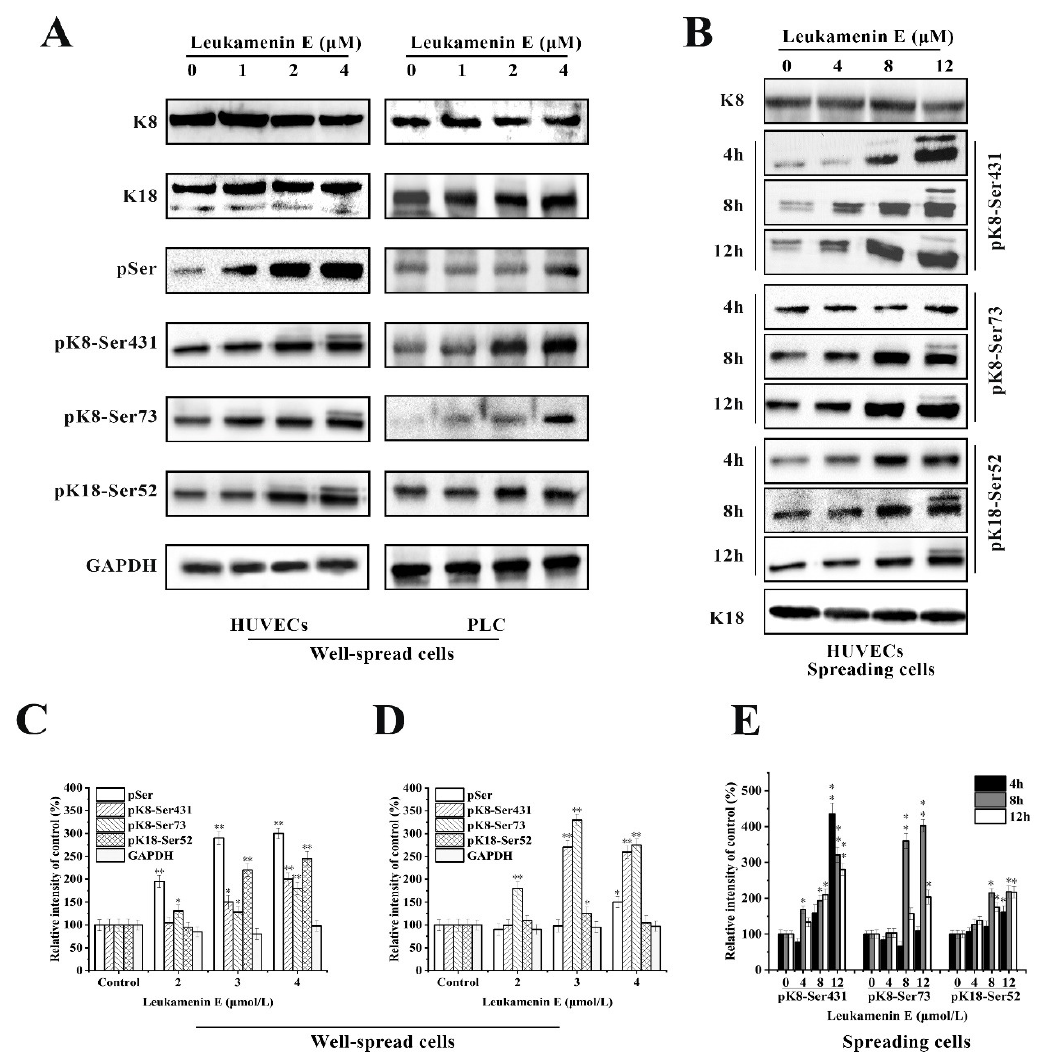
Figure 6. Effects of leukamenin E on keratin phosphorylation in PLC and HUVECs. ( A ) Leukamenin E stimulates phosphorylation of K8 at Ser73 and Ser431 and K18 at Ser52 but does not alter the expression of K8 and K18 in well-spread cells. ( B ) Leukamenin E stimulates phosphorylation of K8 at Ser73 and Ser431 and K18 at Ser52 in spreading cells. ( C – E ) Quantification of keratin or phosphorylated keratin by grey level analysis. The data represent the means ± standard deviation (S.D.) of three independent experiments. * p < 0.05, ** p < 0.01 versus control group.